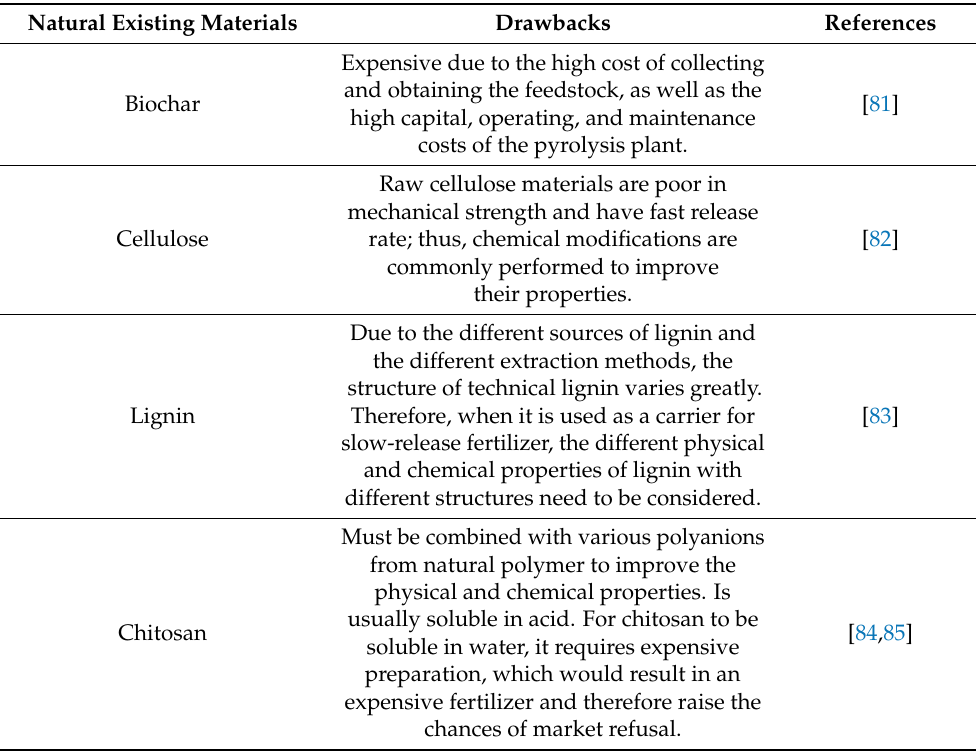
Table 3. Drawbacks of natural existing